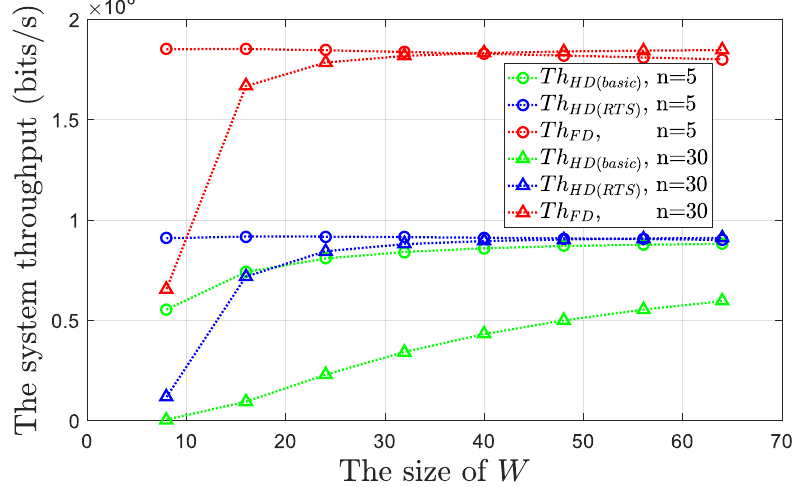
Figure 9. System throughputs for the proposed FD MAC protocol and the traditional CSMA/CA protocol versus the different values of n and W .